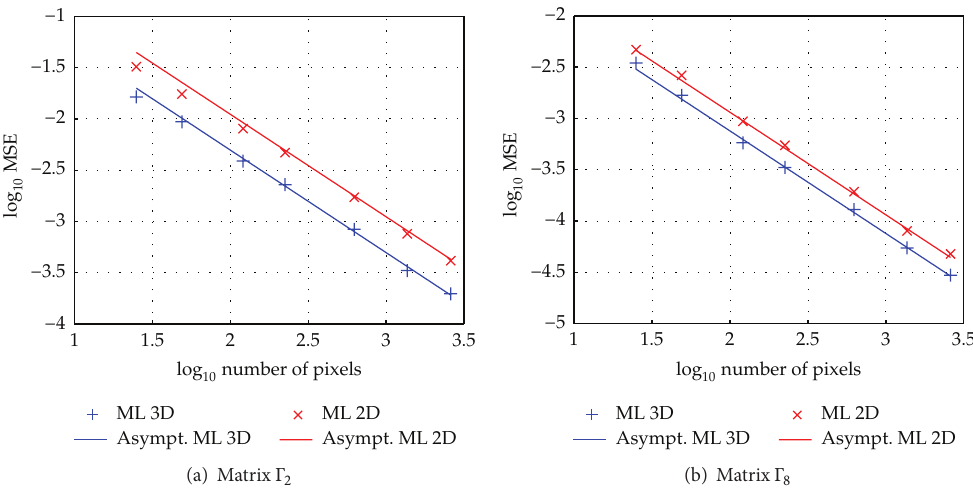
Figure 3: log MSE of the estimated square DoP 𝑃 2 using 2 or 3 intensity images versus the logarithm of the sample size for the matrices (a) Γ Γ 2 and (b) 8 under high flux assumption (ML: maximum likelihood estimators, Asympt.: theoretical asymptotic value of the log MSE for a given estimator).